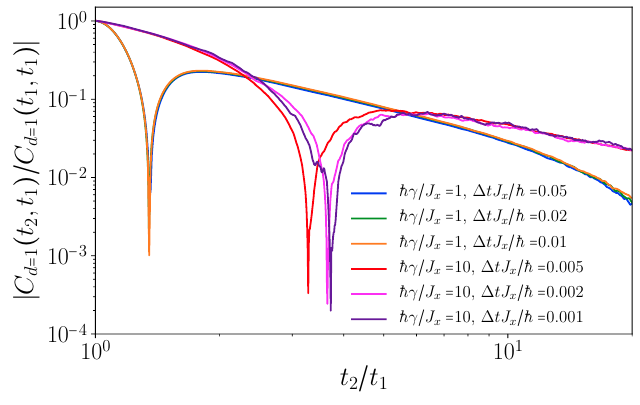
Figure 14: Time step convergence of MCWF approach for different dissipation strengths for a chain of L = 16 spins, J and a bond dimension D = 500. The sample size is 10 4